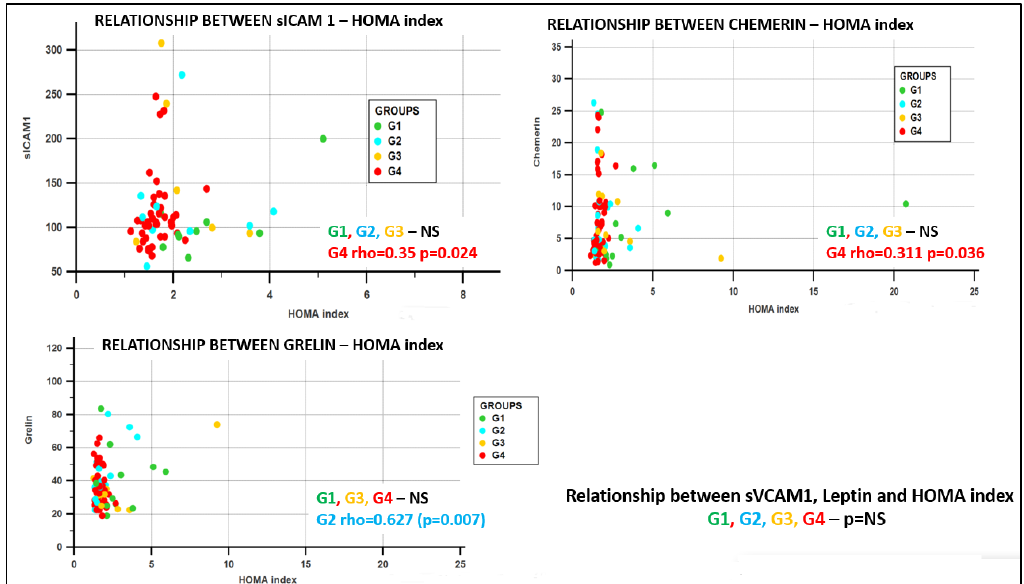
Figure 1. Relationship between the HOMA index (homeostatic model assessment) and adhesion molecules and adipokines. Panel a: relationship between sICAM1 (soluble Intercellular Adhesion Molecule 1) and HOMA index depending on the subjects’ groups; panel b: relationship between chemerin and HOMA index depending on the subjects’ groups; panel c: relationship between ghrelin and HOMA index depending on the subjects’ groups.